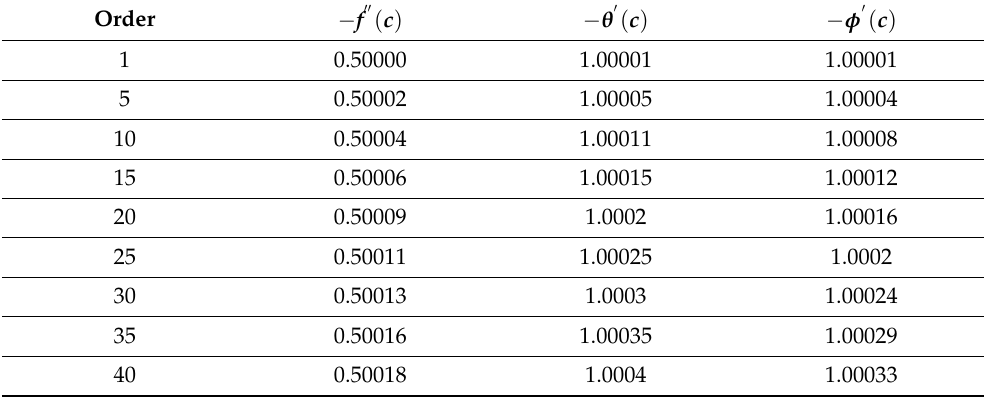
Figure 2. The h -curves of h f , h θ , and h φ . Table 3. Convergences of series φ 1 = 0.01, φ 2 = 0.01, ε = 1, α = 1, Pr = 7, Sr = 0.1, c = M = 0.1, Rd = Du = 0.2, and Sc =